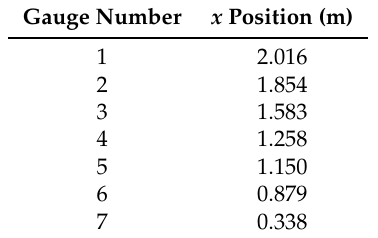
Table 1. Gauge x -positions.